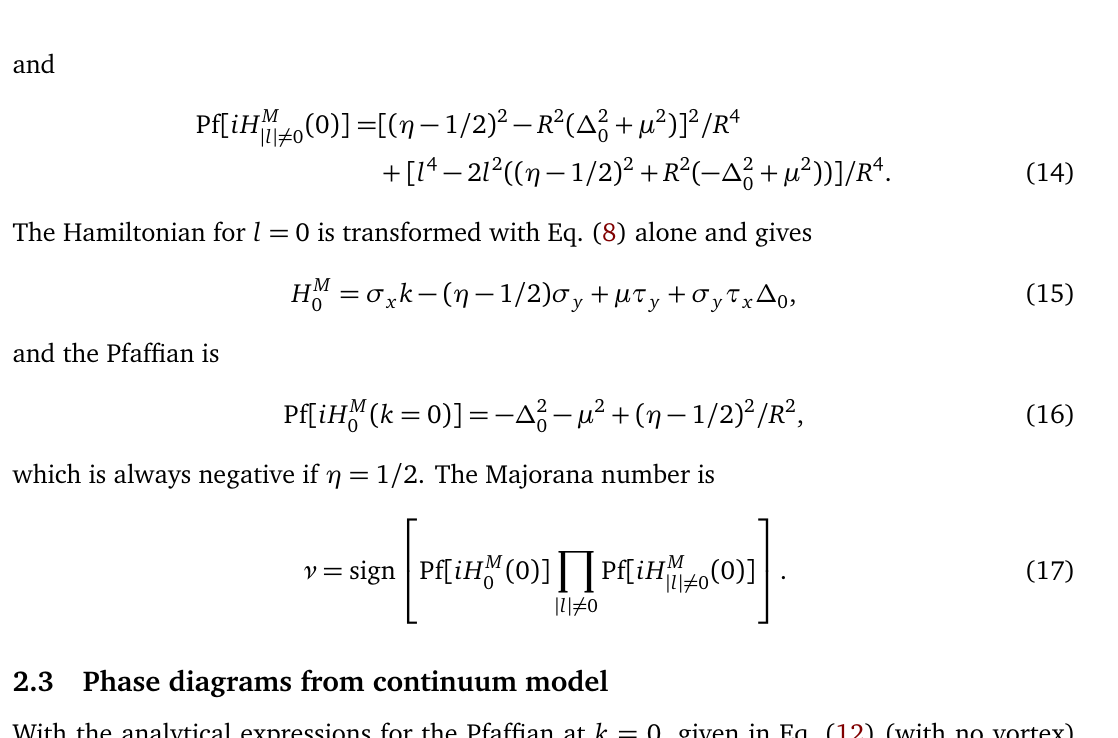
R = 0.1. (b) is the same as 0